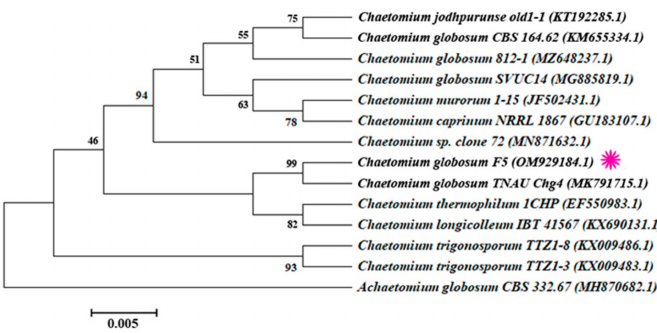
Figure 3. Phylogenetic tree of Chaetomium globosum based on 5.8S rRNA gene sequencing showing similarity with Chaetomium spp. The Neighbor-Joining (NJ) approach was used in MEGA7, with bootstrap values ( n = 1000) greater than 50% apparent at the tree’s internodes. As the outer group, Achaetomium globosum CBS 332.67 strain was included. The purple symbol indicates the position of our isolated endophyte strain (F5).